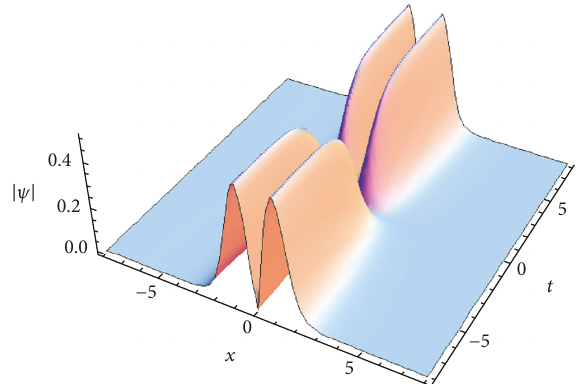
Figure 2: Spatial structure of the module of solution (20) with 𝑞 0 = 3